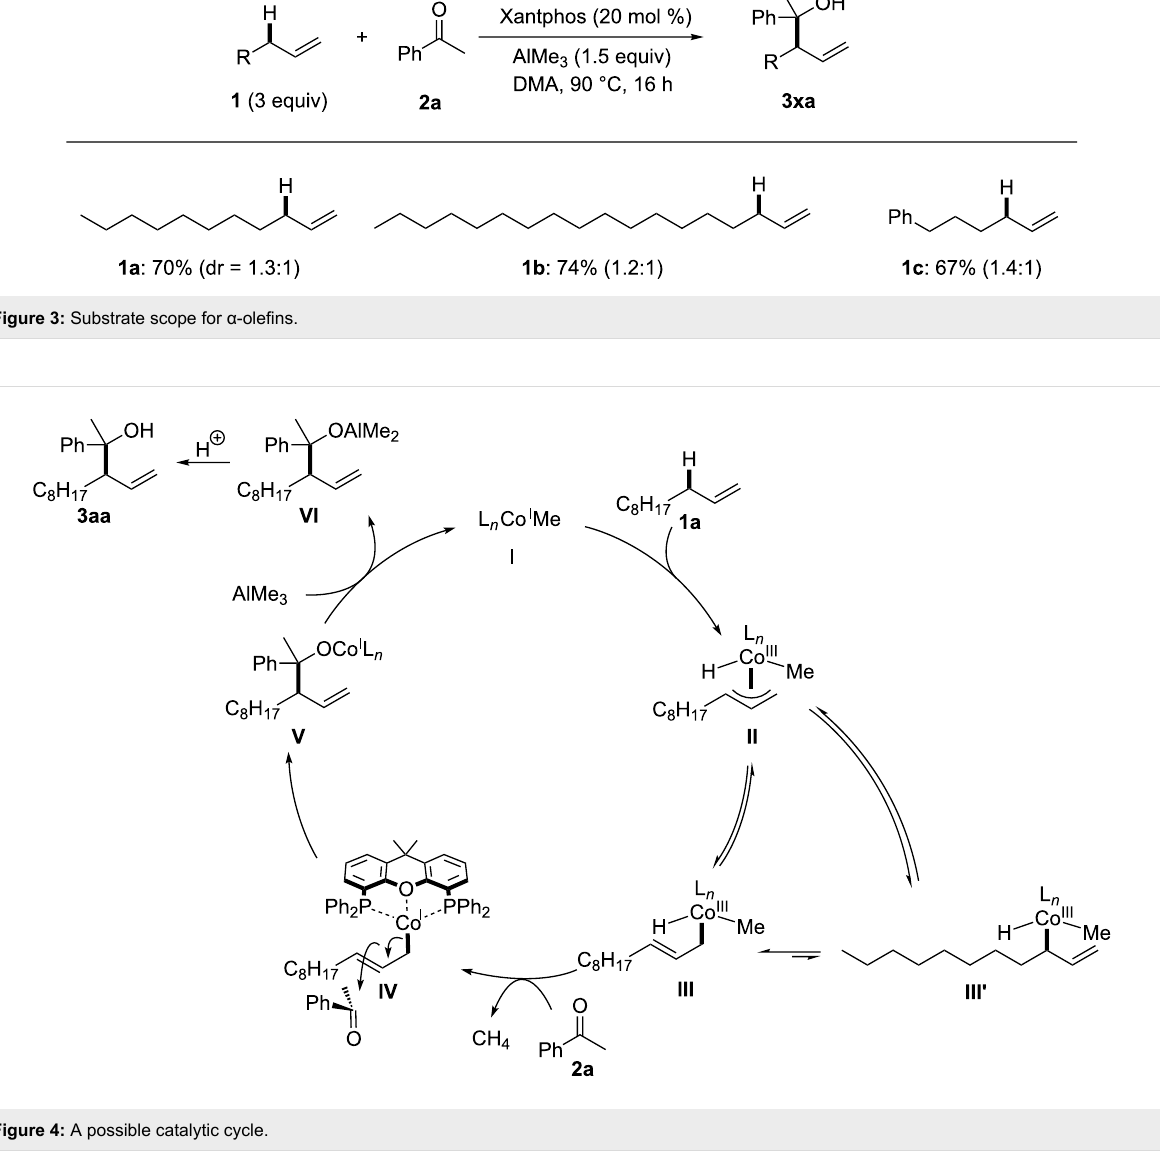
Figure 4: A possible catalytic